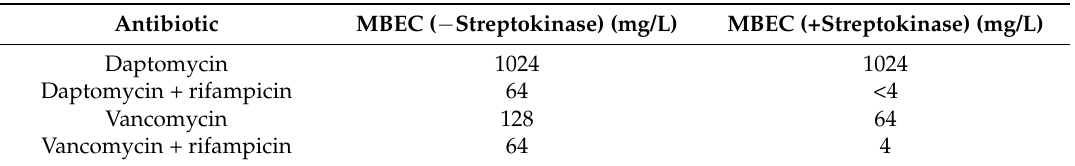
Table 1. Minimal biofilm eradication concentration (MBEC) against biofilms of S. aureus USA300 grown for 24 h in BHI with 50% plasma and incubated with antibiotics in the presence or absence